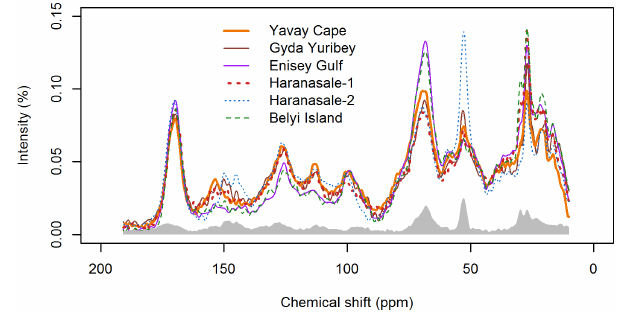
Figure 4. 13 C-NMR spectra of surface soil samples. The grey spec- trum corresponds to the standard deviation of all 13 C-NMR